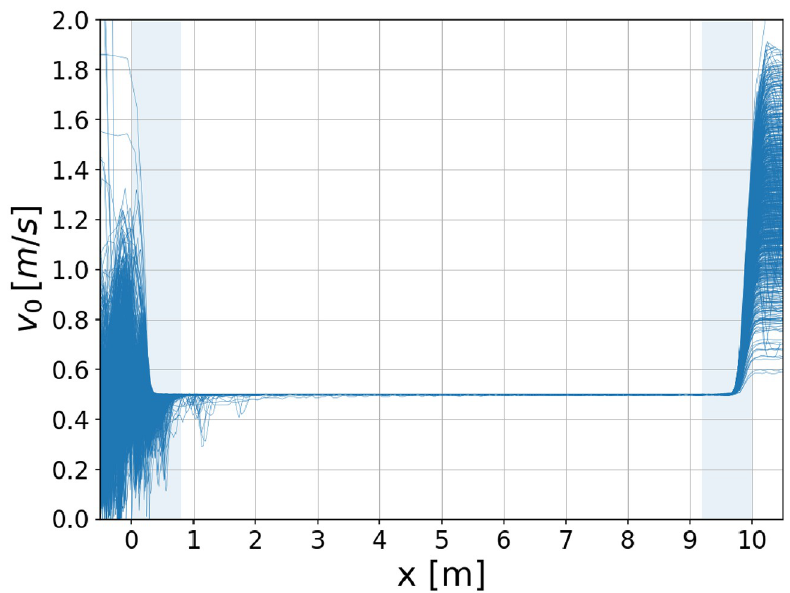
Fig 4. Individual speeds of 1.000 agents, depending on the position on the escalator. The results are obtained using c = 500, v esc = 0.5 ms − 1 , and w = 1.0 m. The shaded areas indicated the required length of the horizontal flights according to Table